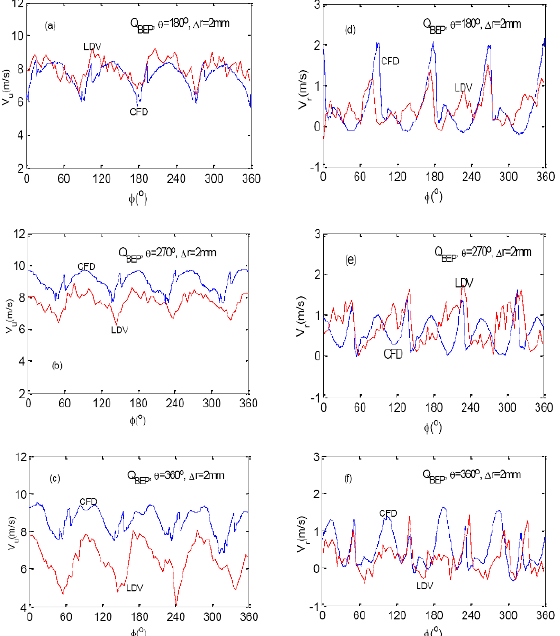
Figure 4. Comparison of CFD estimated unsteady circumferential and radial velocity components of water at point 2mm be- hind impeller with those observed by LDV at part-loading point.